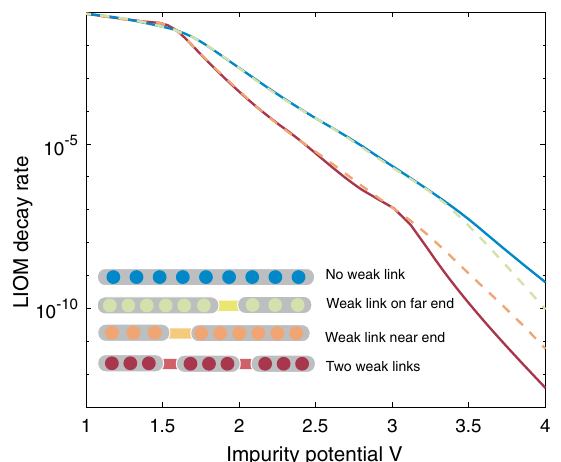
FIG. 5. Self-consistent rate: residual decay rate of the asymp- totic variational Birkhoff approximation of the integral of motion associated with the impurity spin, connected to a chain with weak links as a function of the impurity potential V . The weak links are 1 = 2 V . The blue line shows chosen self-consistently like J eff ¼ the results with no weak links, the red with weak links after every third site, the dashed orange line is the result if only the weak links closest to the impurity are taken into account, and the dashed green line if only the second closest weak link were to be there. The results highlight that the decay is suppressed only by weak links that appear at a distance before the crossover scale n (cid:4)